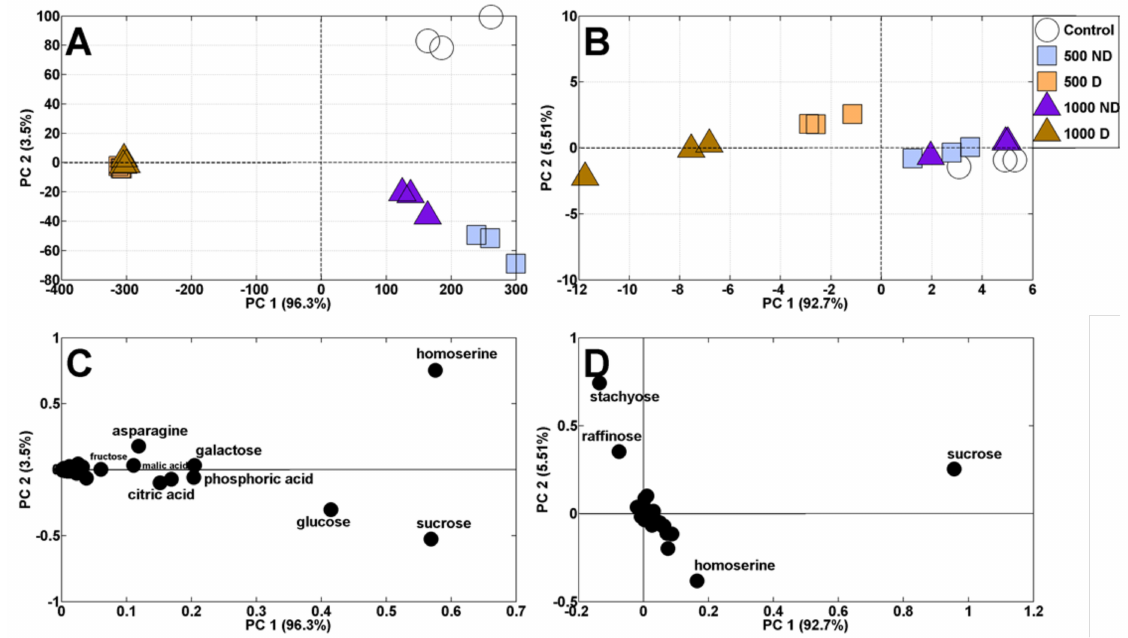
Figure 4. PCA profiles of polar metabolites in sprouts ( A ) and cotyledons ( B ) of 4-day-old pea seedlings from seeds imbibed in water (Control) or AgNO 3 at concentrations of 500 and 1000 mg/L. The non-deformed and deformed sprouts were signed as ND and D, respectively. The PCA loading plots of the polar metabolites in sprouts and cotyledons are present on ( C , D ),